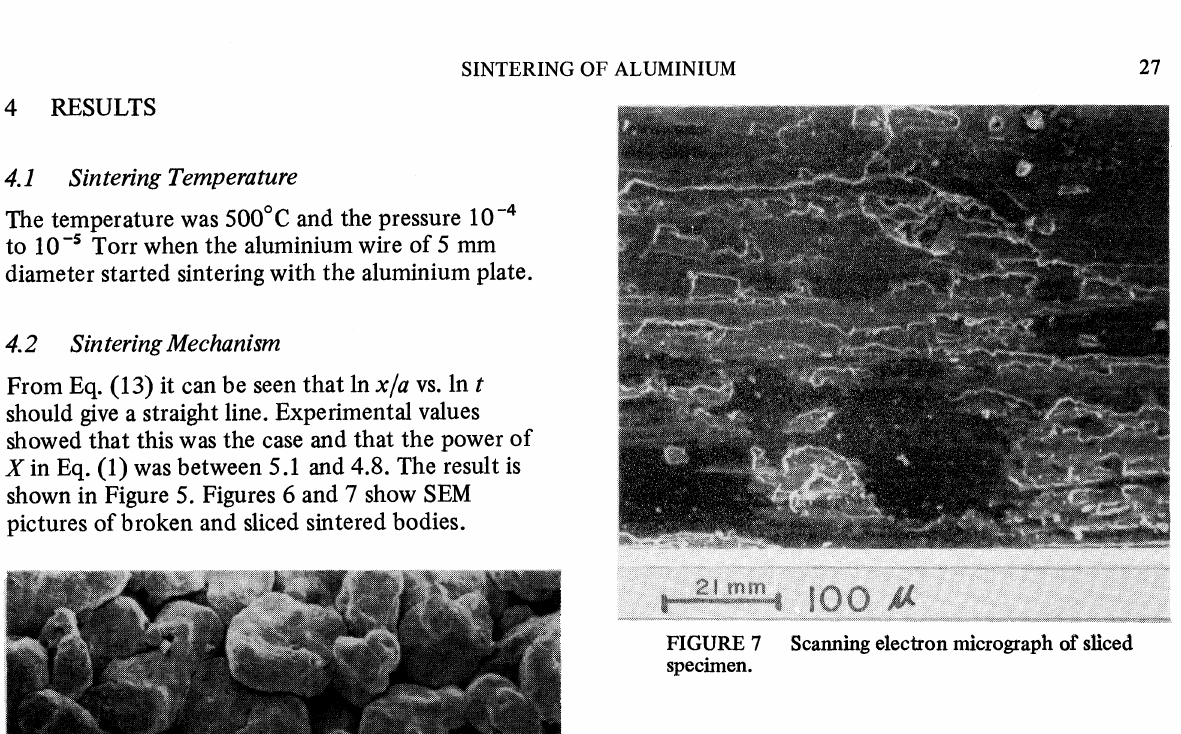
Scanning electron micrograph of broken